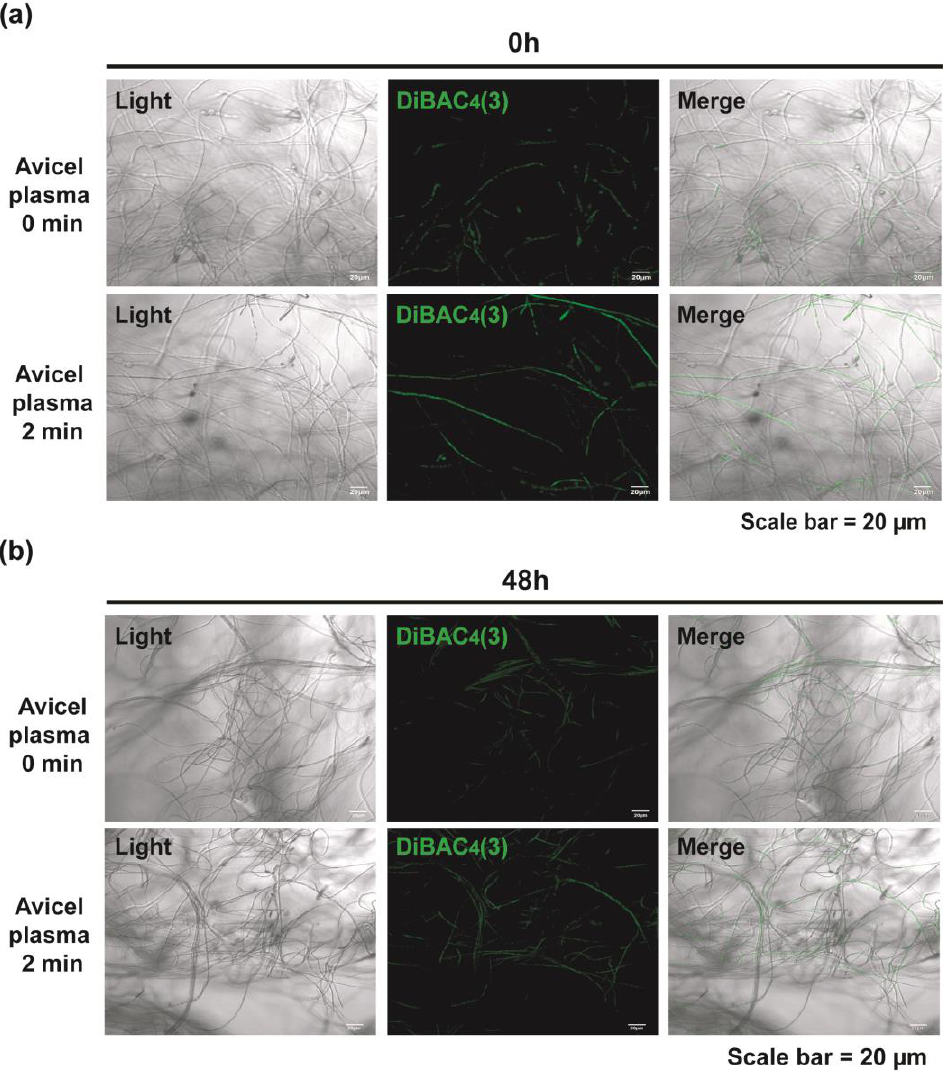
Figure 9. Assay for membrane potential using DiBAC 4 (3) in fungal hyphae at 0 ( a ) and 48 h ( b ) after plasma treatment for 2 min in Avicel-containing media.